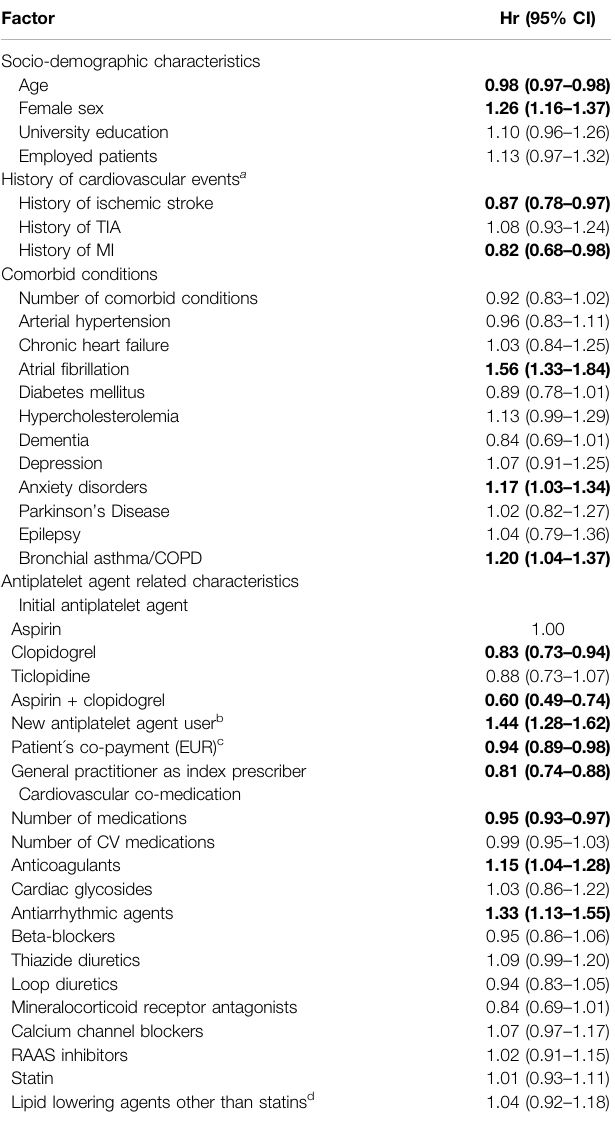
TABLE 2 | Multivariate analysis of the association between patient- and medication-related characteristics and the likelihood of non-persistence ( n (cid:1)